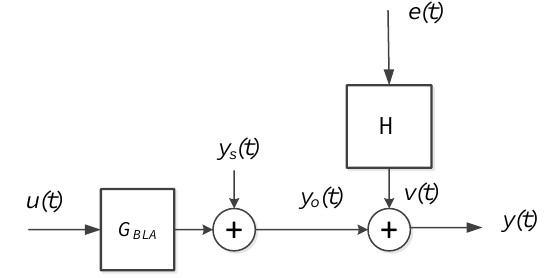
Figure 2: Best linear approximation of the weakly non- linear